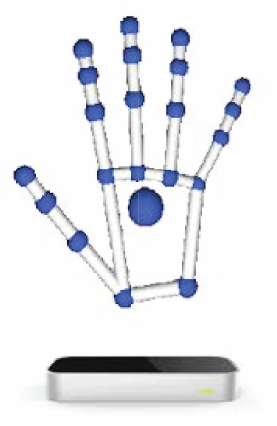
Figure 1: The position of hand that Leap Motion used to recognize all the joints and